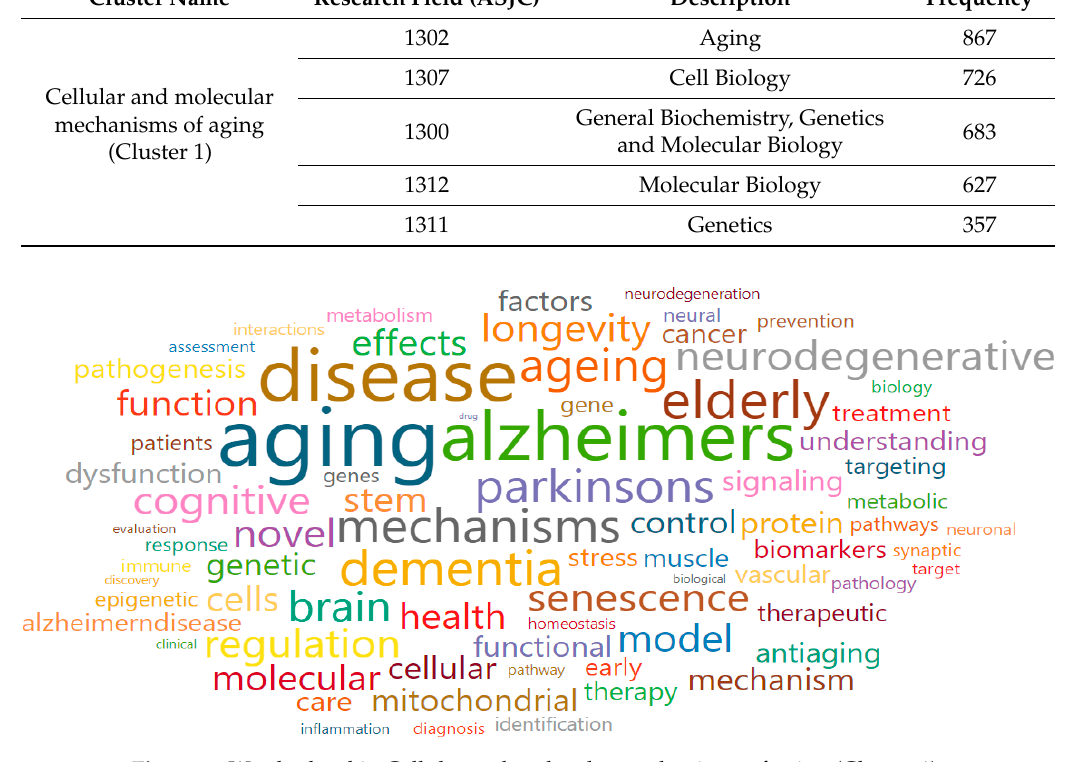
Figure 6. Words cloud in Cellular and molecular mechanisms of aging (Cluster 1).